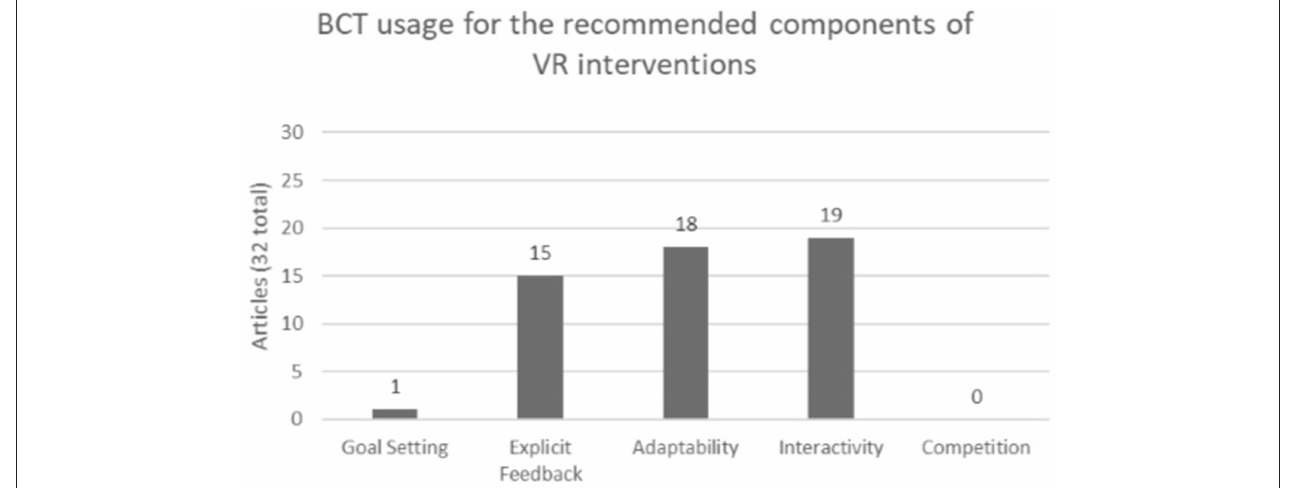
FIGURE 3 | Summary of BCT usages in respect to the 5 recommended components of VR interventions across all 32